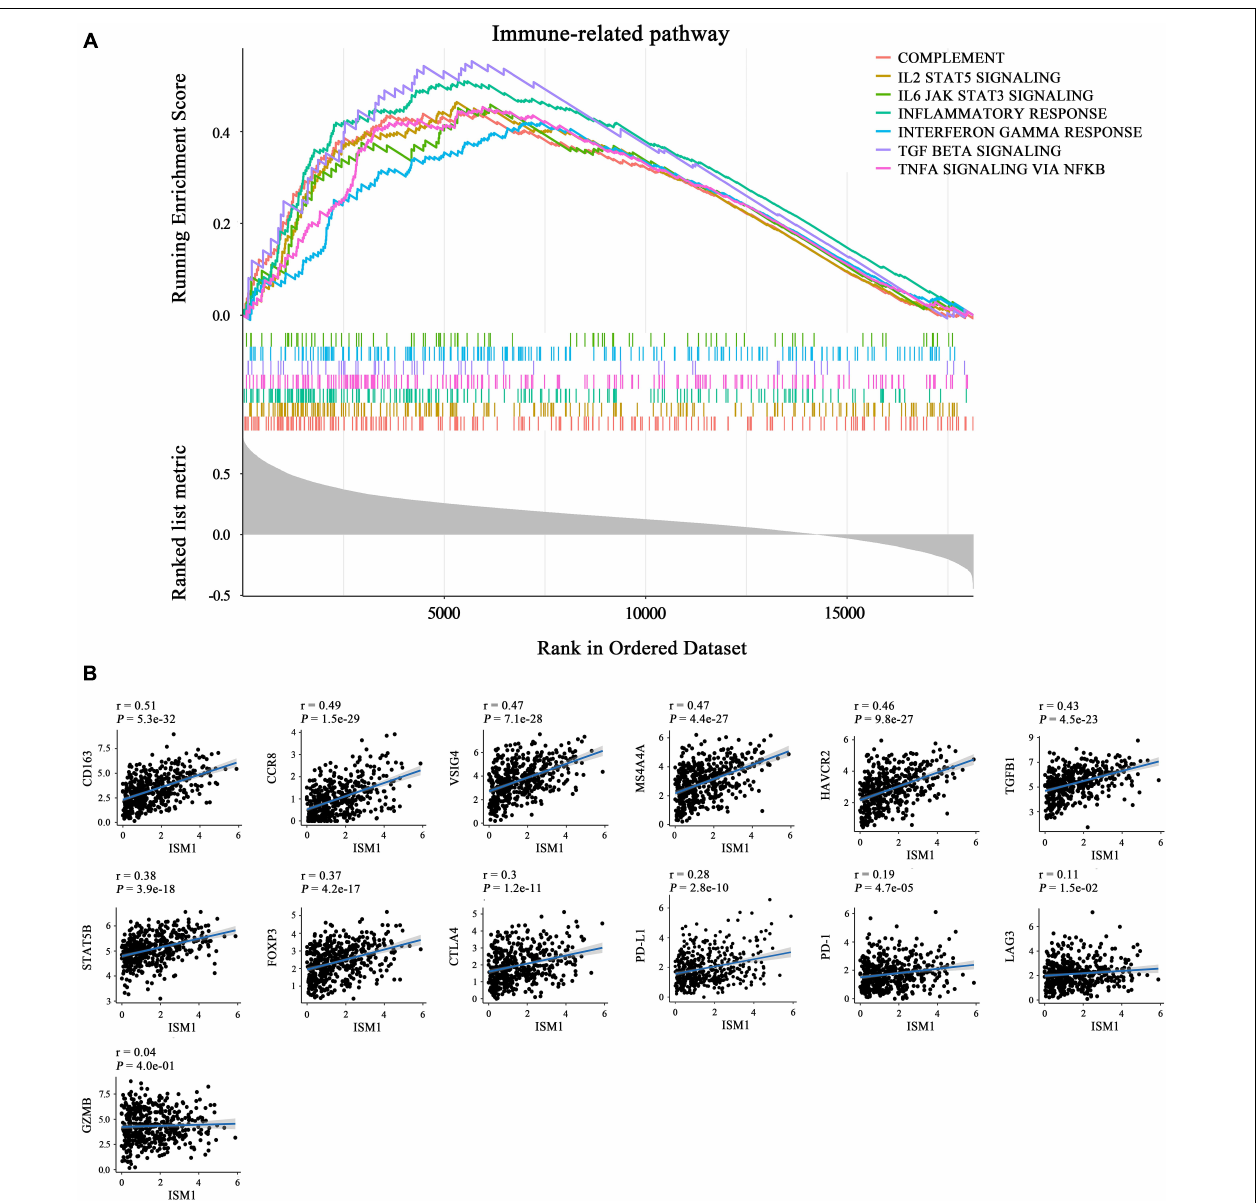
FIGURE 6 | Role of ISM1 in an immunosuppressive microenvironment. (A) Seven significantly enriched ISM1-related immunosuppressive pathways in CRC. The short vertical lines in the middle of the figure represent the distribution of ISM1-related genes among the 19505 genes. (B) Correlation between ISM1 and immunosuppressive markers of M2 macrophages (CD163, VSIG4, and MS4A4A), Tregs (CCR8, TGFB1, STAT5B, and FOXP3), and T cell exhaustion (TIM-3, CTLA-4, PD-1, and LAG3) and PD-L1. Correlation strength is defined as follows: “0.00–0.29” indicates weak; “0.30–0.59” indicates moderate; “0.60–1.0” indicates strong. P < 0.05 is statistically